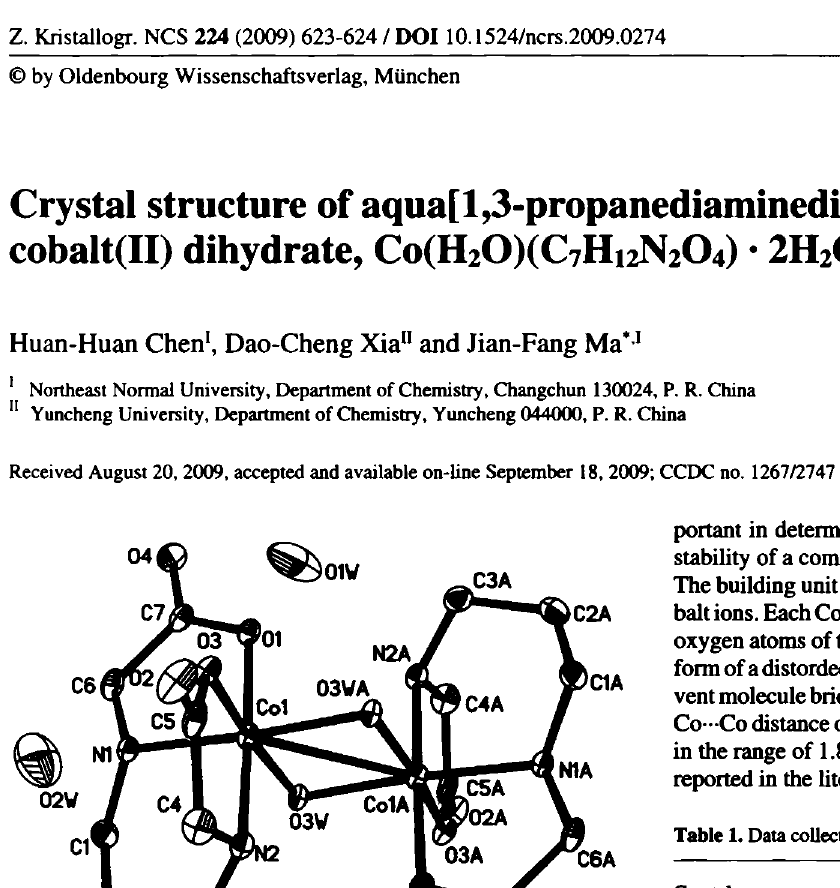
Table 1. Data collection and handling.